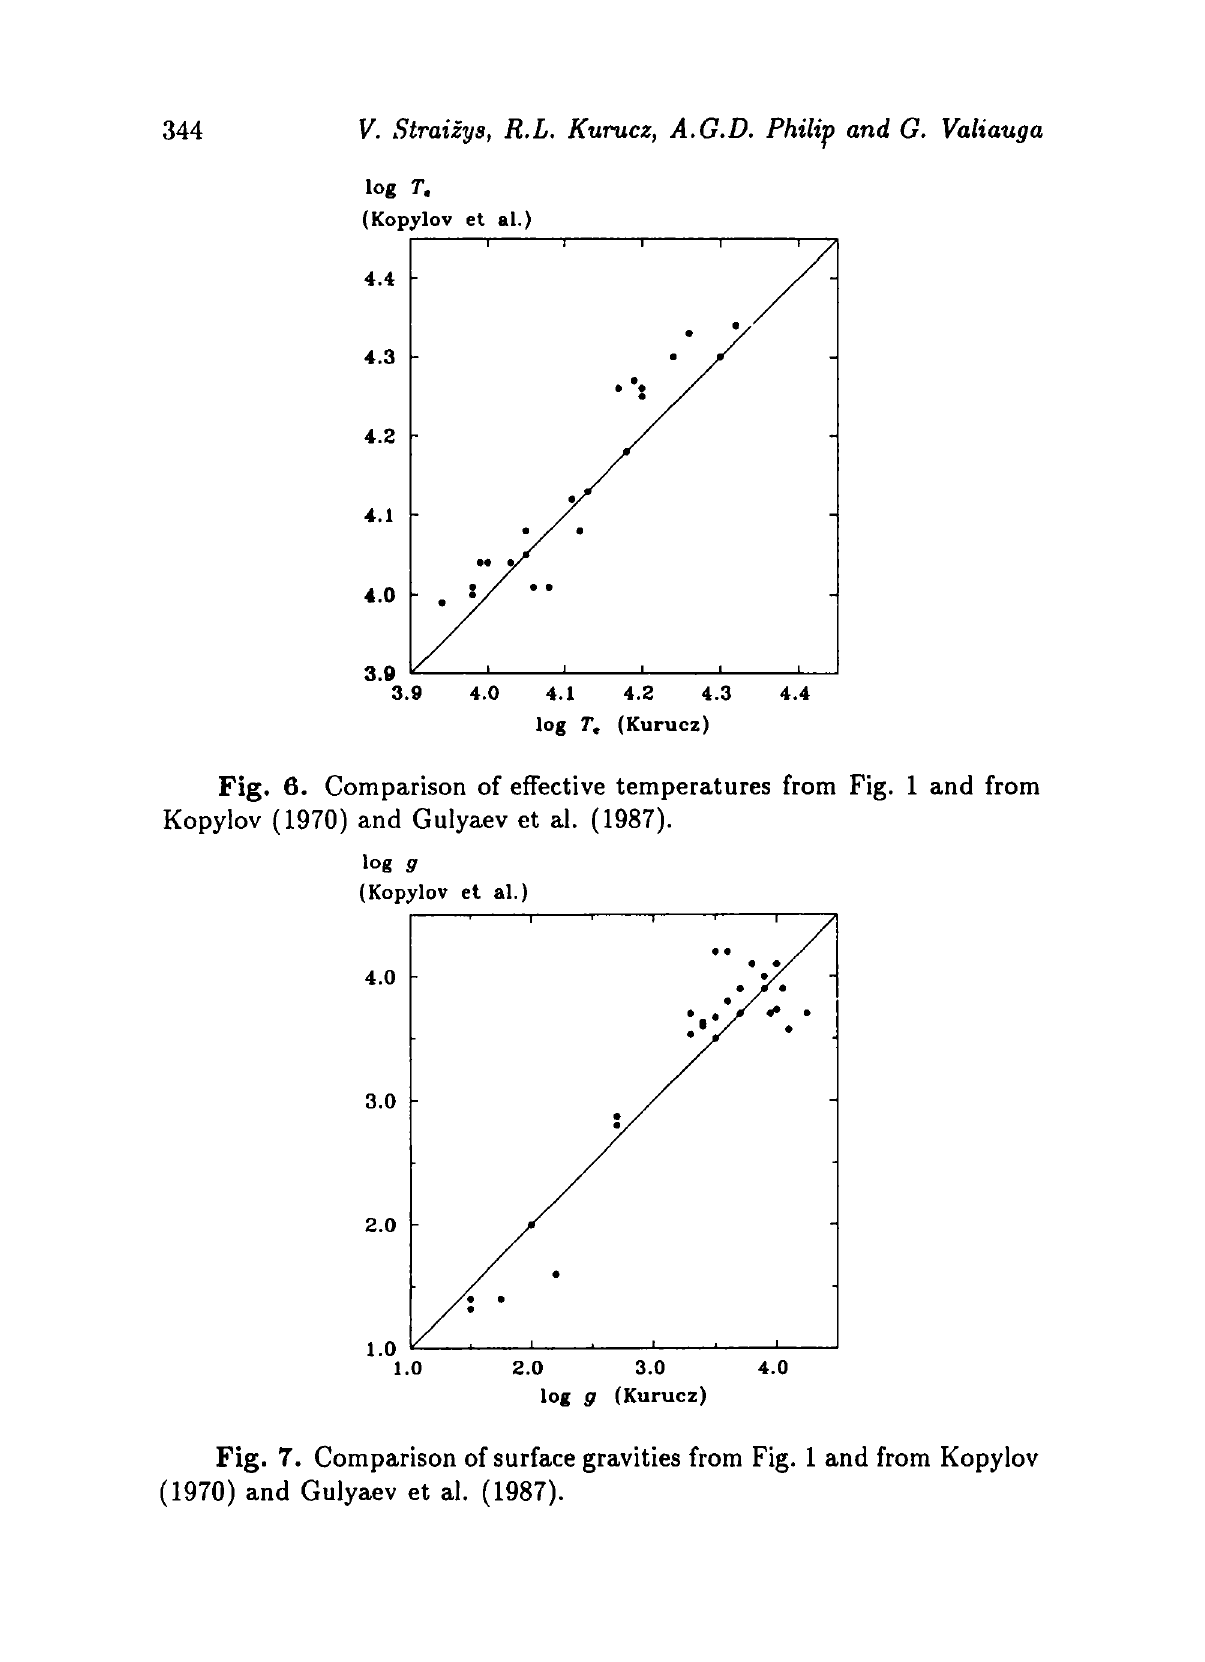
Fig. 7. Comparison of surface gravities from Fig. 1 and from Kopylov (1970) and Gulyaev et al.